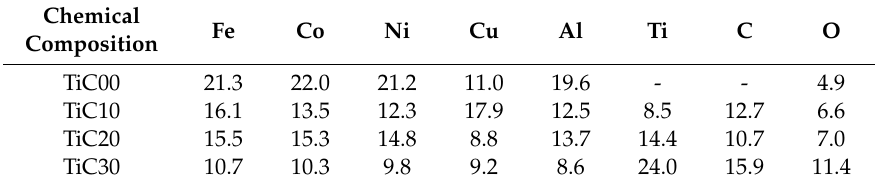
Table 3. Chemical compositions of the surface wear-tested at room temperature, in atomic percentage.